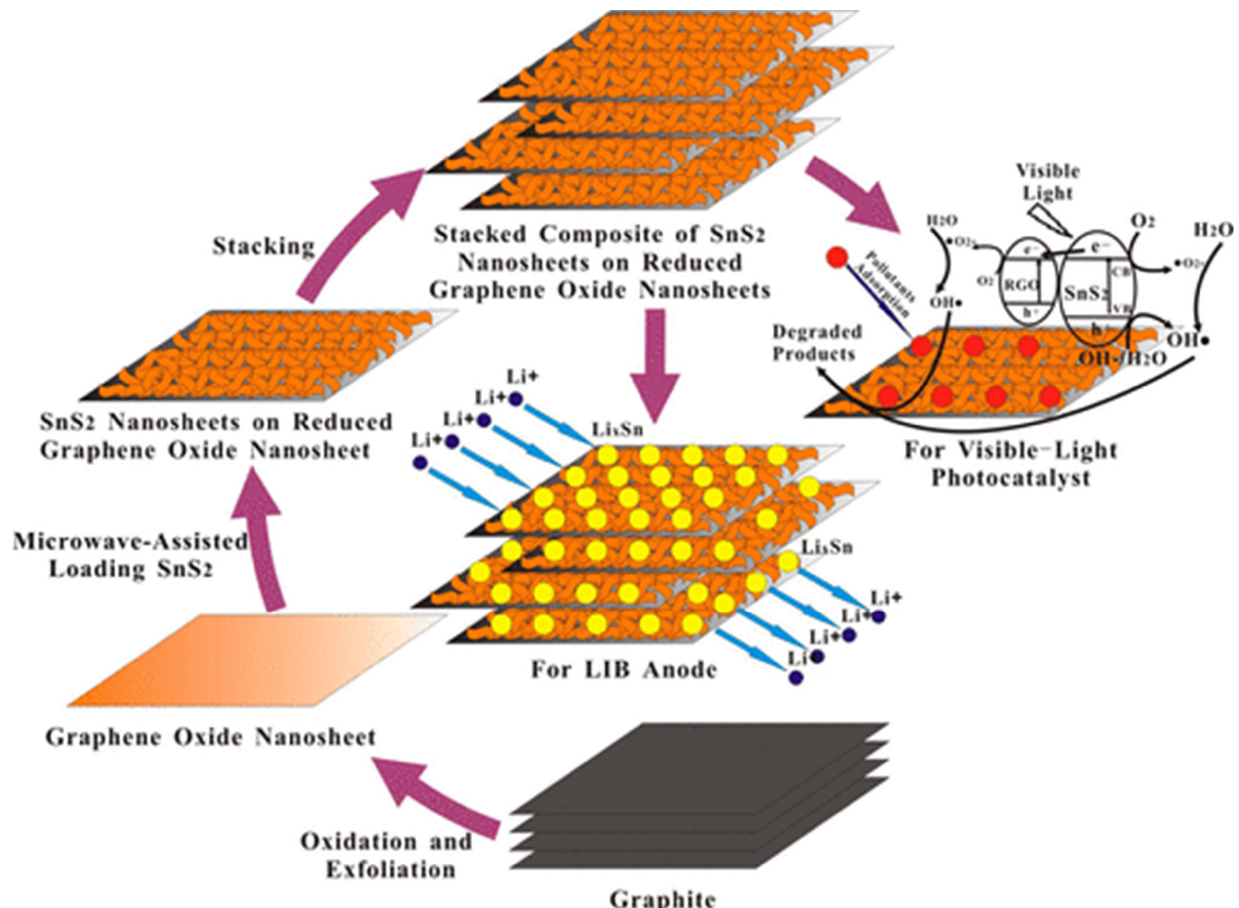
Figure 3. Schematic illustration of the growth process and applications of SnS 2 –RGO sheet-on-sheet nanostructure. Reproduced with permission of ref. [101]. Copyright 2013. American Chemical So- ciety.